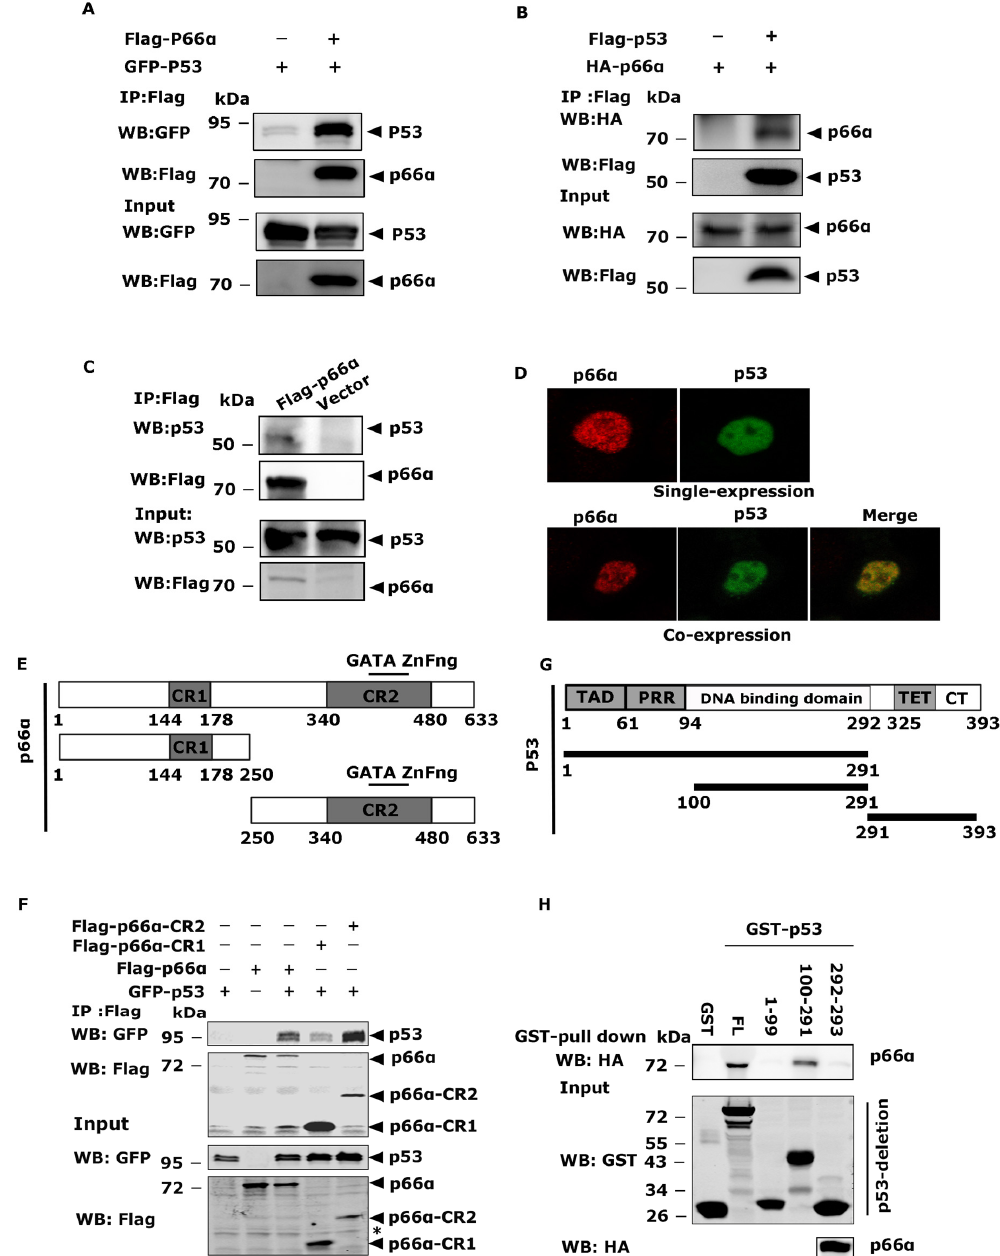
Figure 3. p66 α directly binds the DNA-binding domain of p53. ( A ) The exogenously expressed Flag-p66 α and GFP-p53 proteins interacted in HEK-293T cells. Immunoprecipitation was performed by using Flag M2 beads to enrich p66 α , and